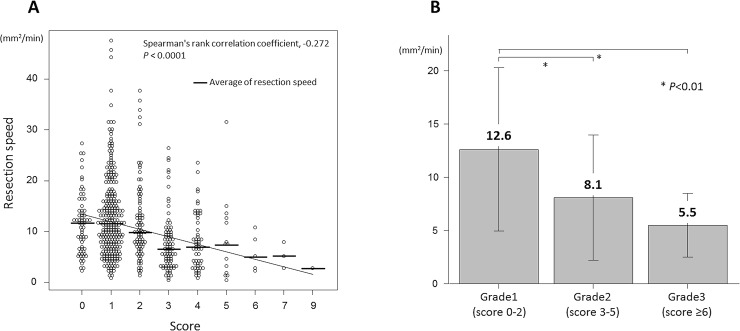
Association between the score and the resection speed.(A) The rank correlation coefficient between the score according to the scoring system and the resection speed. (B) The mean resection speed for three grades.